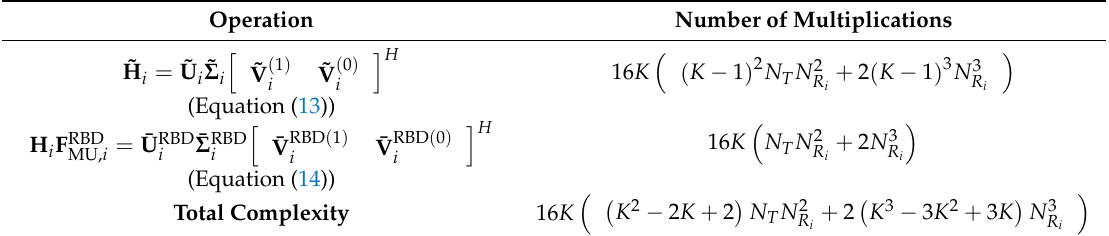
Table 3. Computational complexity for a regularized block diagonalization (RBD) precoder.